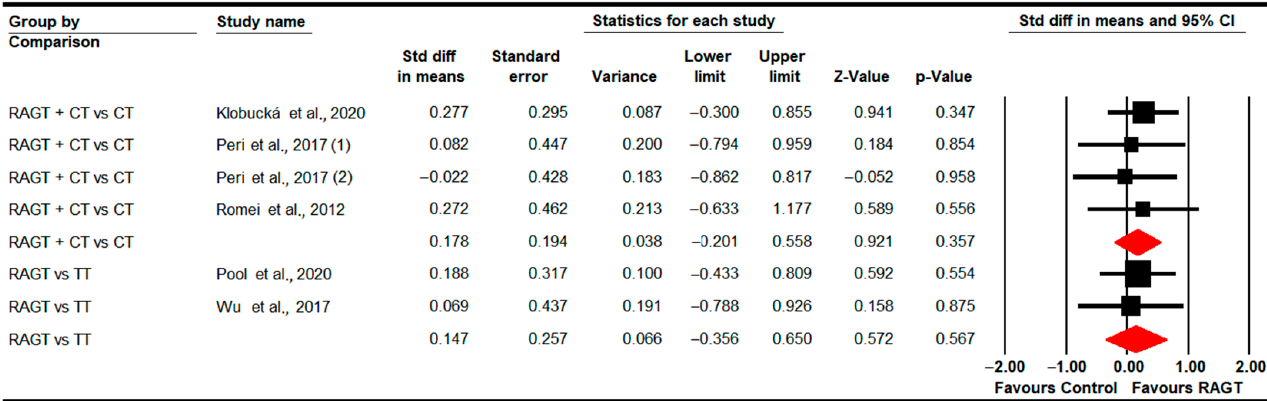
19 of 27 Figure 9. Forest plot of walking, running and jumping ability (Post-Intervention Assessment) [78,79,81,83,84,87,89,91]. Subgroup analysis reported that at 2 months follow-up, no statistically significant differences were present between RAGT and TT (SMD 0.16; 95% CI − 0.35 to 0.7; p = 0.53), nor at 3 months follow-up between RAGT plus CT vs. CT (SMD 0.02; 95% CI − 0.41 to 0.44; p = 0.92). 3.4.9. Gross Motor Function (Total Score) Five studies [83,87,89–91] provided data to assess the effect of RAGT on total gross motor function in the post-intervention assessment. Two studies with two independent